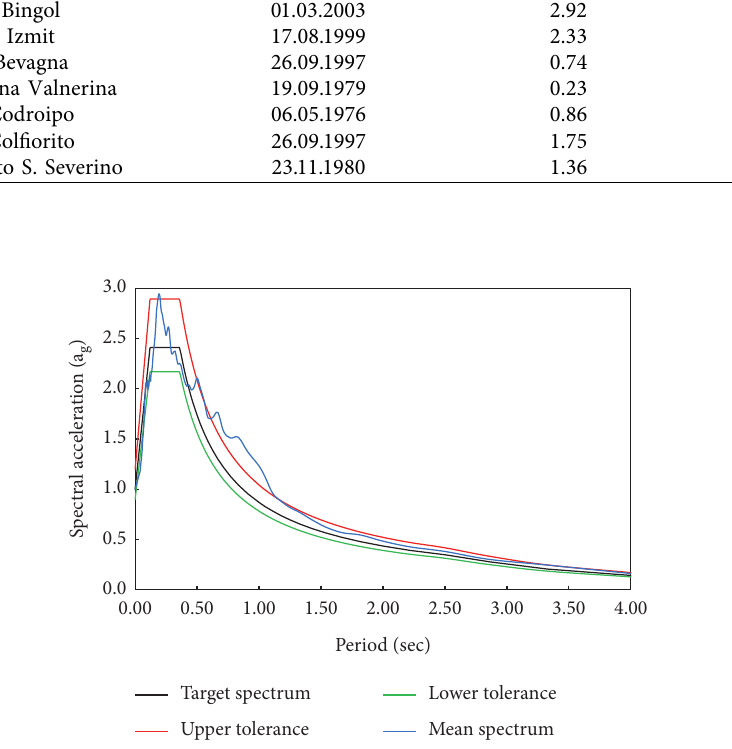
Figure 4: Spectrum compatibility for the selected